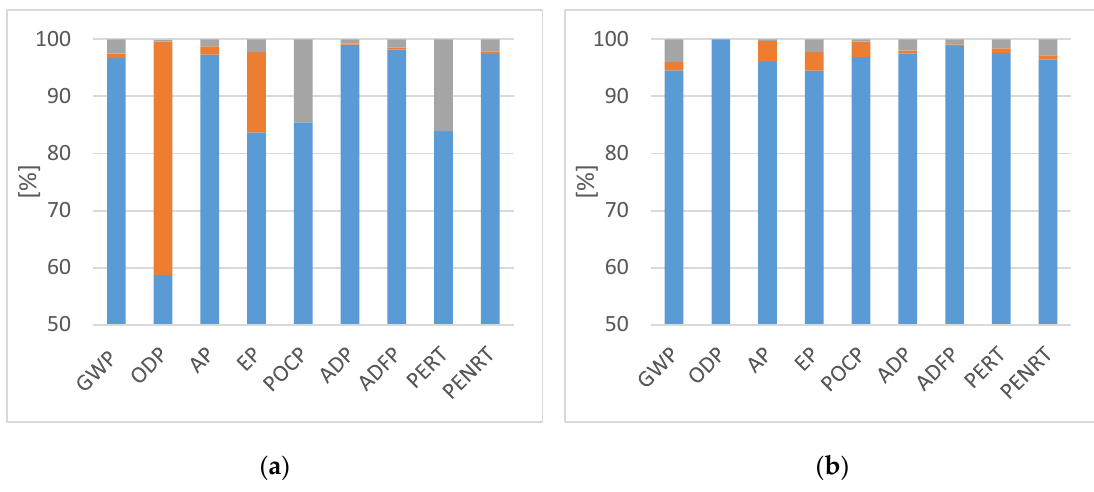
Figure 4. Environmental impact of ETICS (10 cm EPS) with mineral render with an indication of the main environmental impact categories at di ff erent A1-A3 LCA stages ( a ) data from 2012 and ( b ) data from 2017. Legend: ( (cid:4) ) A1 stage, ( (cid:4) ) A2 stage, and ( (cid:4) ) A3 production